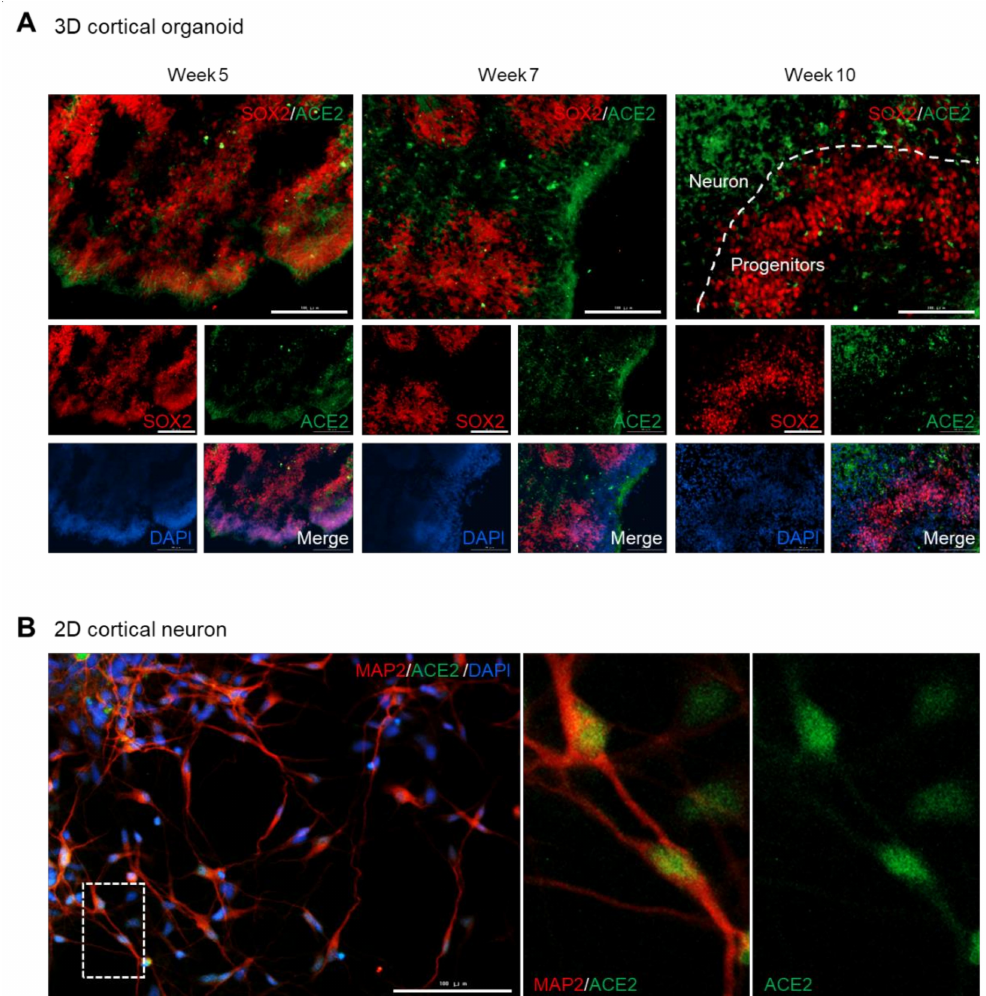
Figure 3. Somas of mature neurons, but not progenitor cells, express ACE2. ( A ) Immunofluorescence of dorsal forebrain organoids collected at di ff erent timepoints after di ff erentiation for detecting SOX2 and ACE2. ( B ) Immunofluorescence of monolayer cultured cortical neurons collected 38 days after di ff erentiation for detecting MAP2 and ACE2. Scale bar, 100 µ